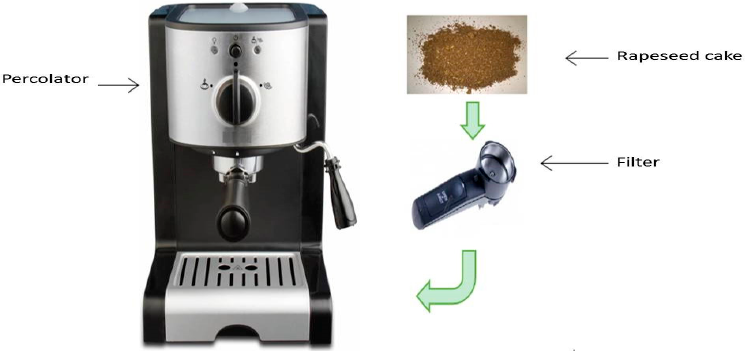
Figure 12. Percolation extraction of proteins from rapeseed cake.